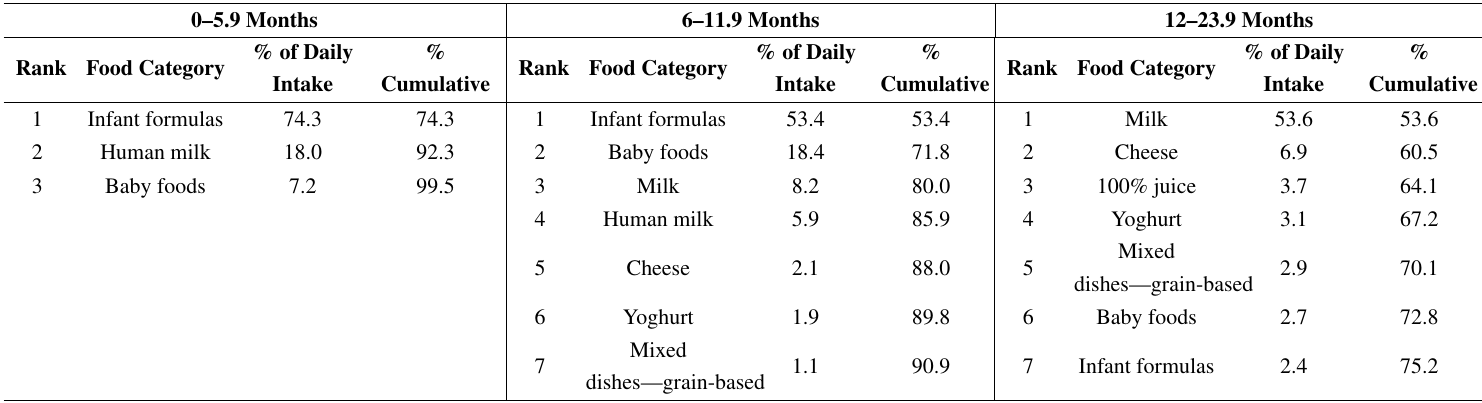
Food sources of potassium among US infants and toddlers aged 0–23.9 months by age group: NHANES 2005–2012 ( n = 2740) a